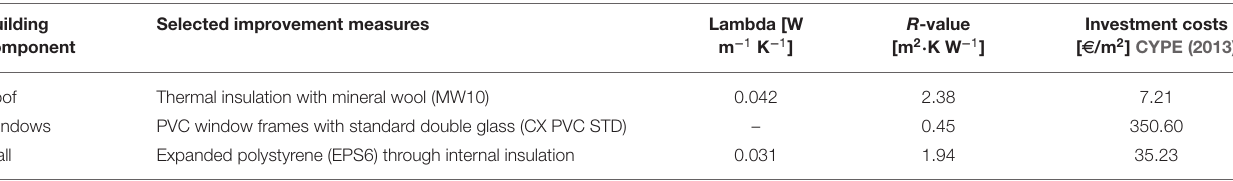
TABLE 2 | Selected measures for buildings